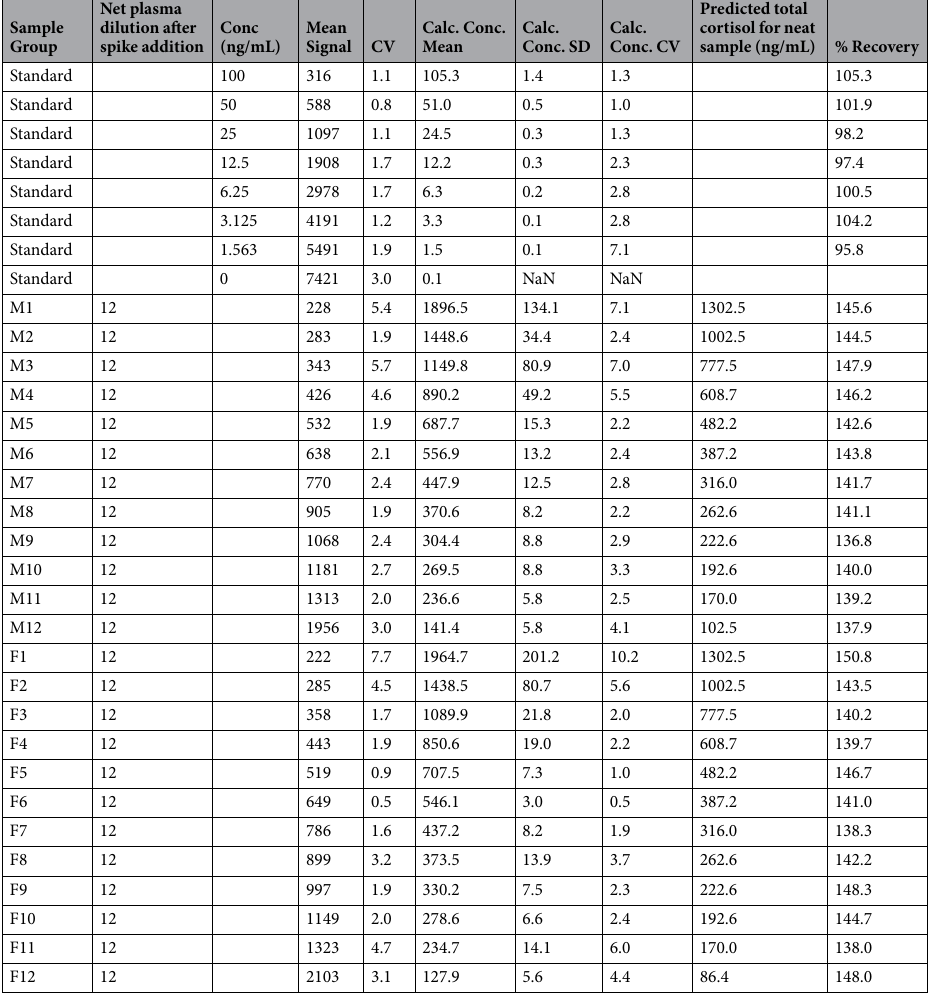
Table 1. A summary of the signal outputs and backfitted concentrations and recoveries of cortisol. Data are shown for male NIST sera (M1 − 12) and female NIST sera (F1 − 12) ± exogenous cortisol CRM spikes obtained by conventional relative quantification from the 4-PL fit curve using the default MSD